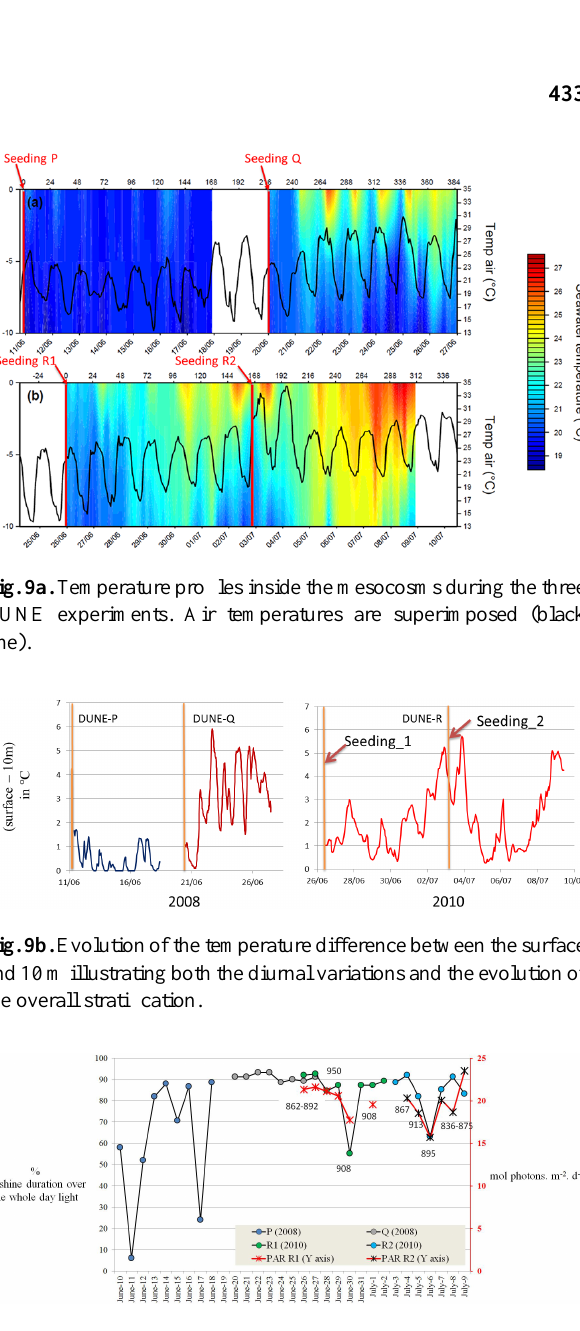
Fig. 9c. Percentage of sunshine duration over the total daytime hours ( ∼ 15h in June–July) (Météo-France): PAR measurements for R1 and R2 ( y axis), the integration for the whole day acquisi- tion are presented in molphotonsm − 2 d − 1 at the subsurface of the mesocosms, and the maximum flux values in µmolphotonm − 2 s − 1 are